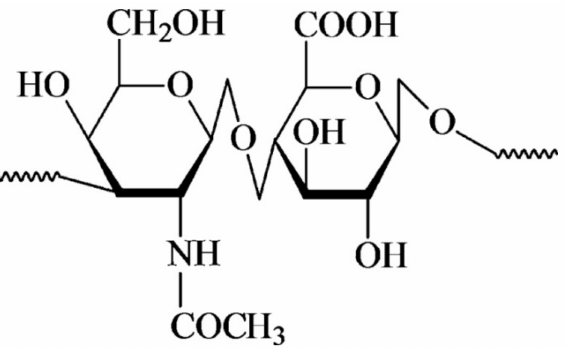
Figure 2. Chemical structure of HYH. Reproduced with permission [24]. Copyright Taylor & Francis